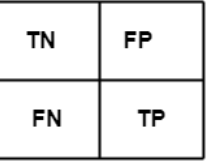
Figure 30. The confusion matrix.